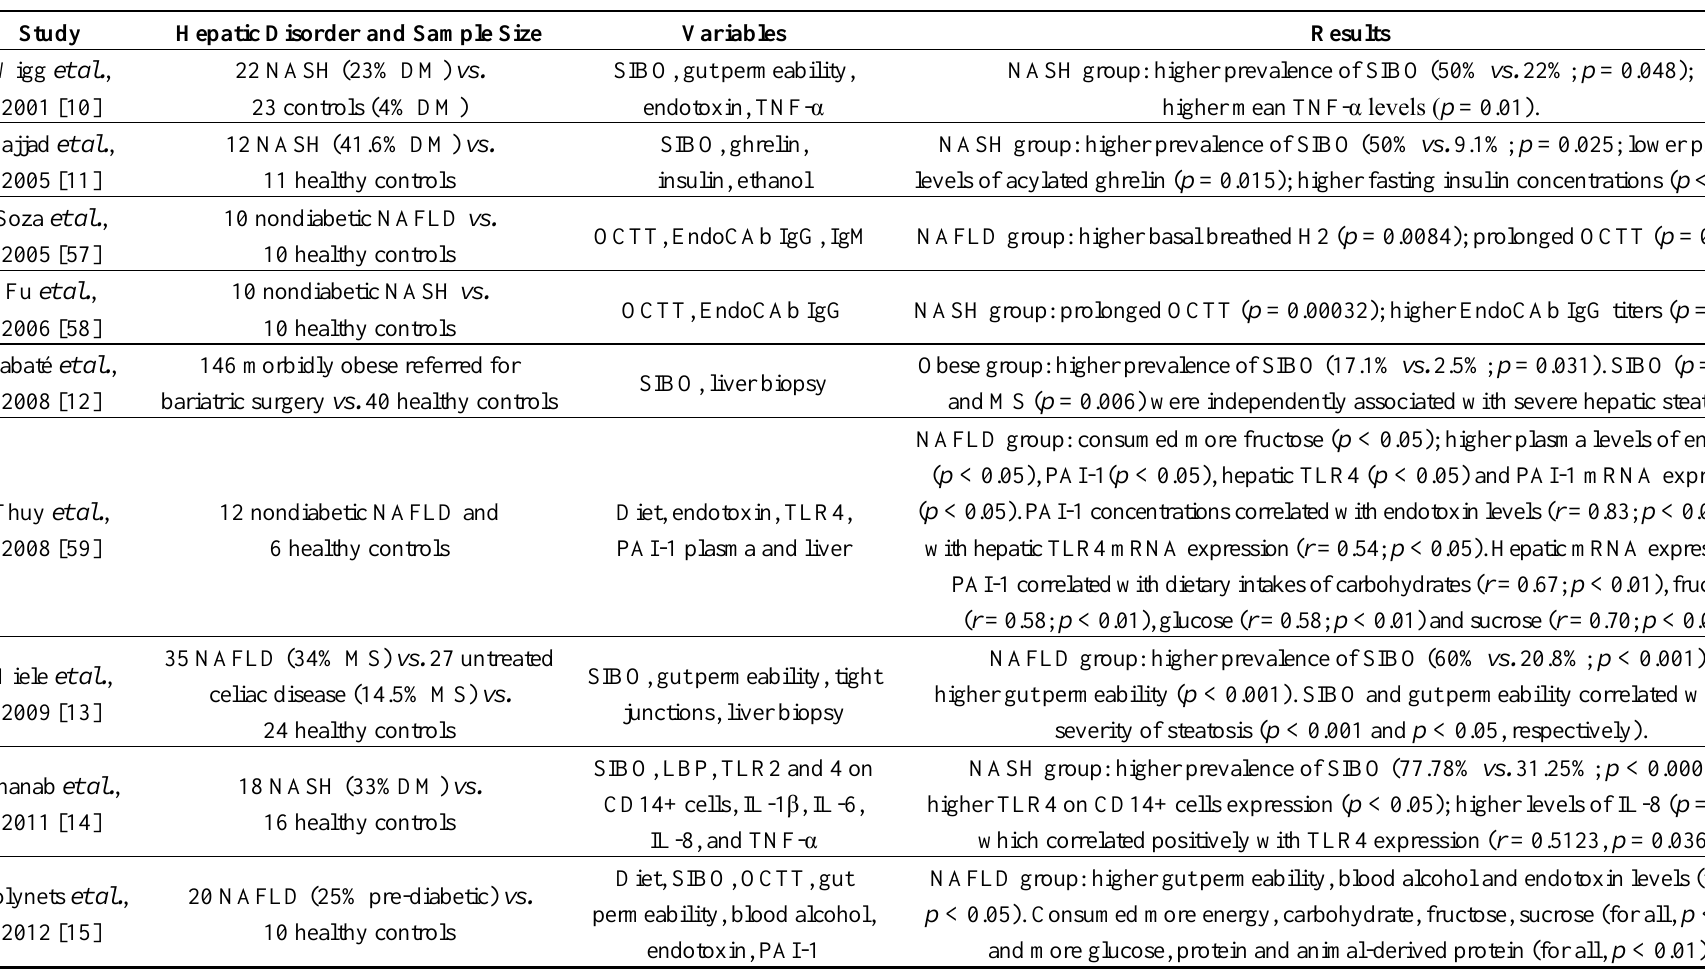
Table 1. Summary of the clinical trials evaluating SIBO, gut permeability and endotoxemia in human